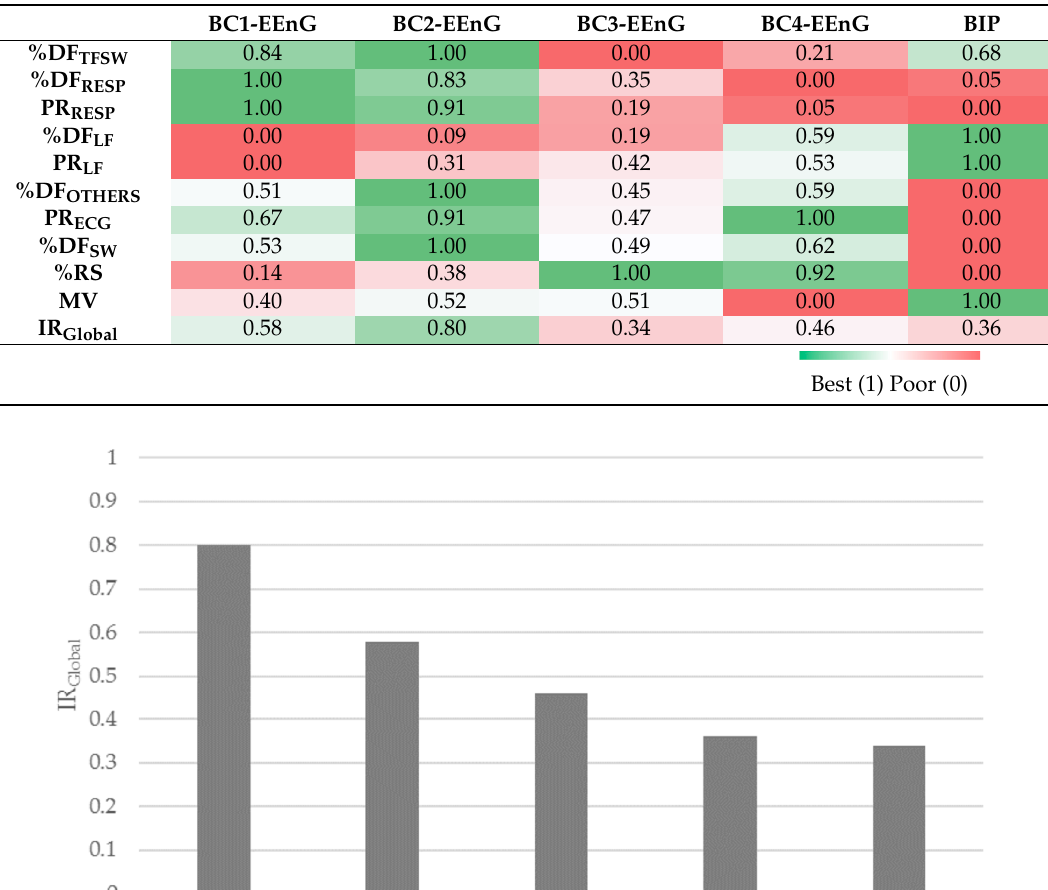
11 of 17 Figure 6. IR Global for each combination of factors: configuration (MC: monopolar concentric; BC: bipolar concentric), material (Ad: adhesive; Fo: foam) and position (AN: above navel; BN: below navel). The color scheme in Table 5 shows the best and worst combinations when considering all parameters in a global approach. This is clearest in the IR Global values given in Figure 6. It can be seen that in general, the lowest IRs and IR Global are from the records from AN with foam for both MC and BC (BCFoAN and MCFoAN). The best IRs seem to concentrate in the combination of BC with adhesive and BN ition(BCAdBN), which obtained the highest IR Global values (0.7), followed by MCAdBN and BCFoBN, with values around 0.6. 3.3. Selection of the Best Ring Size of CRE and Comparison with Conventional Bipolar Recording After identifying the best combination of CRE recording factors to capture the SW, the next step was to study the influence of ring dimensions on the values of the characteristic EEnG parameters. The influence of the electrode dimensions was analyzed for the BC-EEnG configuration in BN